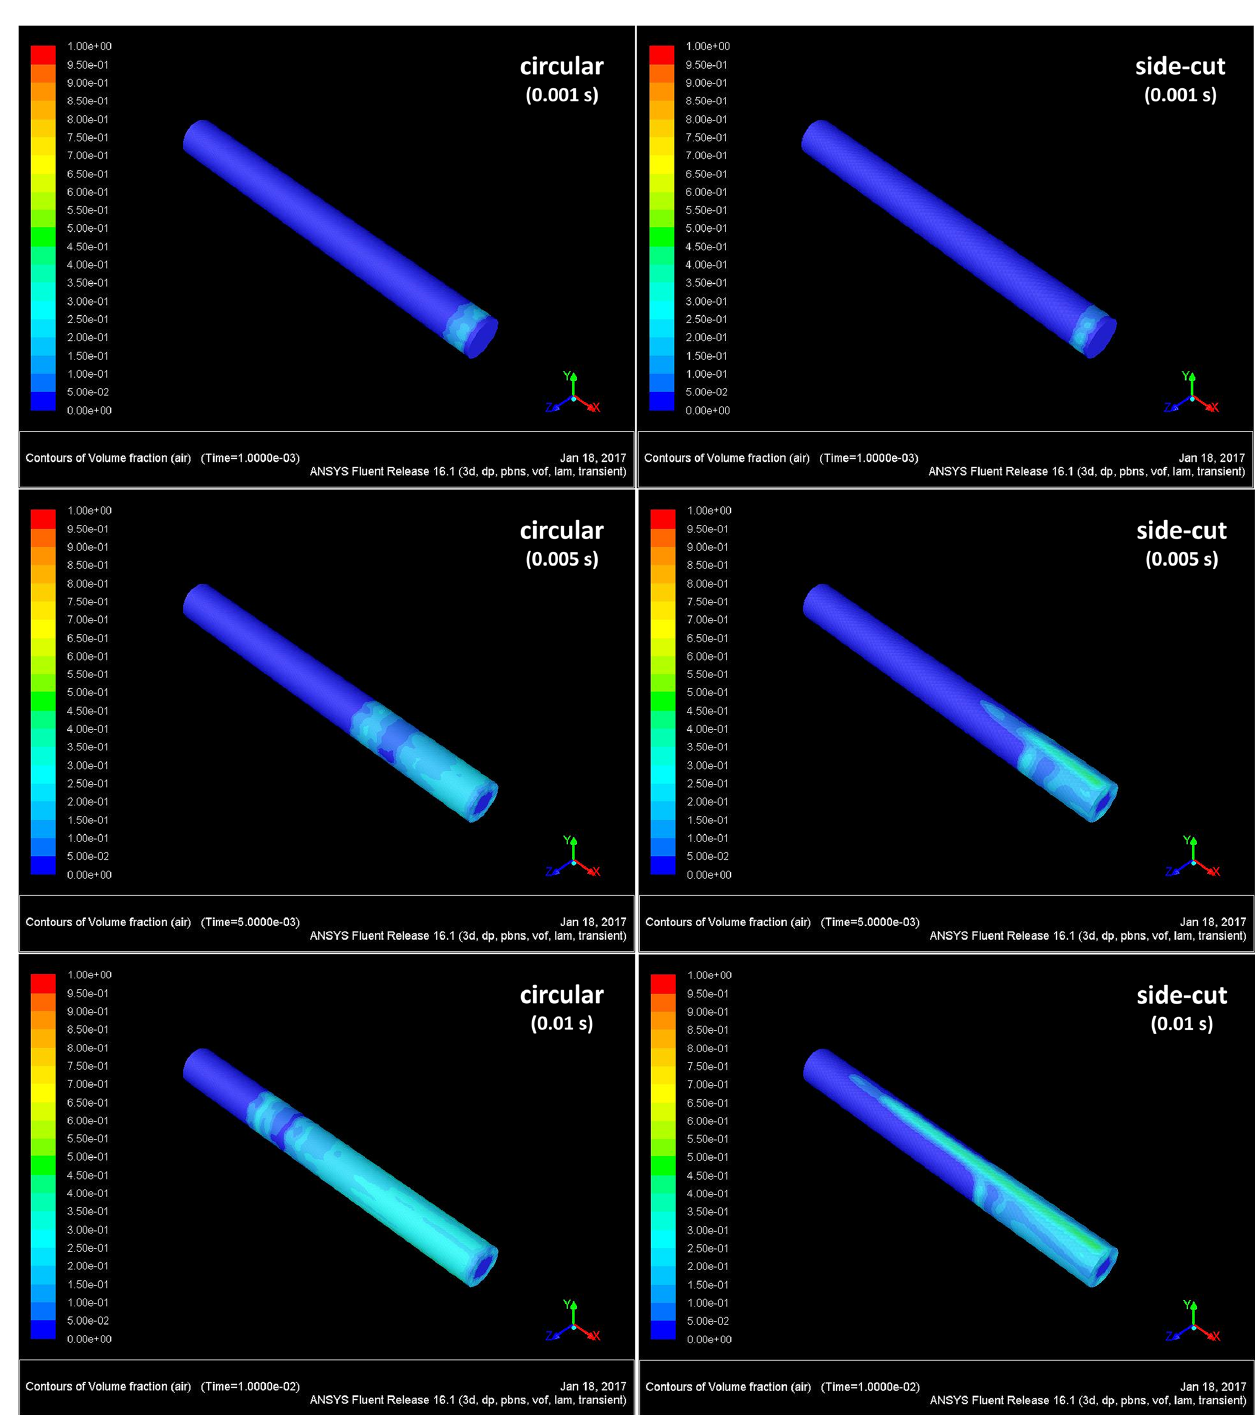
Figure 13. Volume fraction contours of bubbles at increasing time